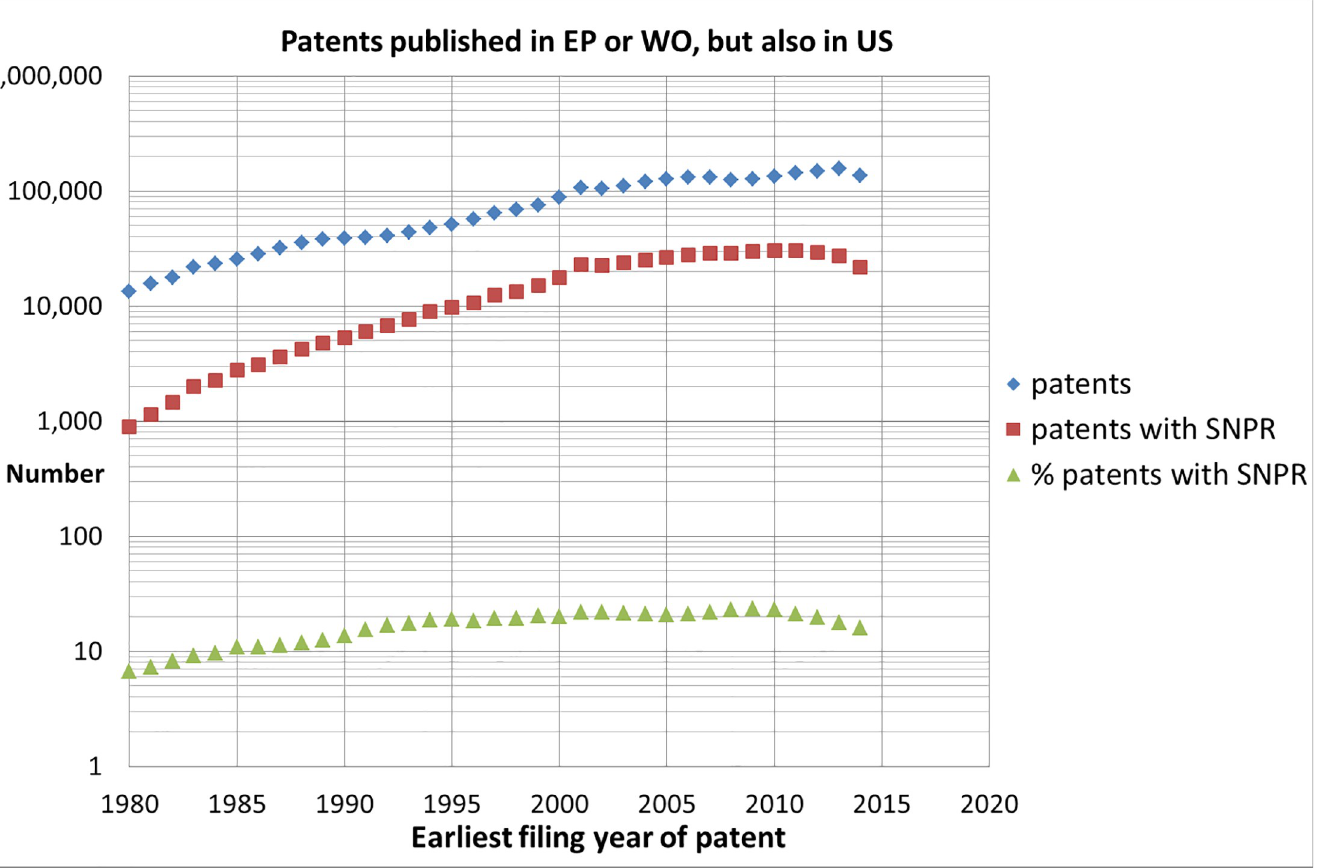
Fig 17. Trend of the total number of patents with at least a patent publication in EP or WO but also in the US; the trend of patents with SNPRs, as well as the percentage of these